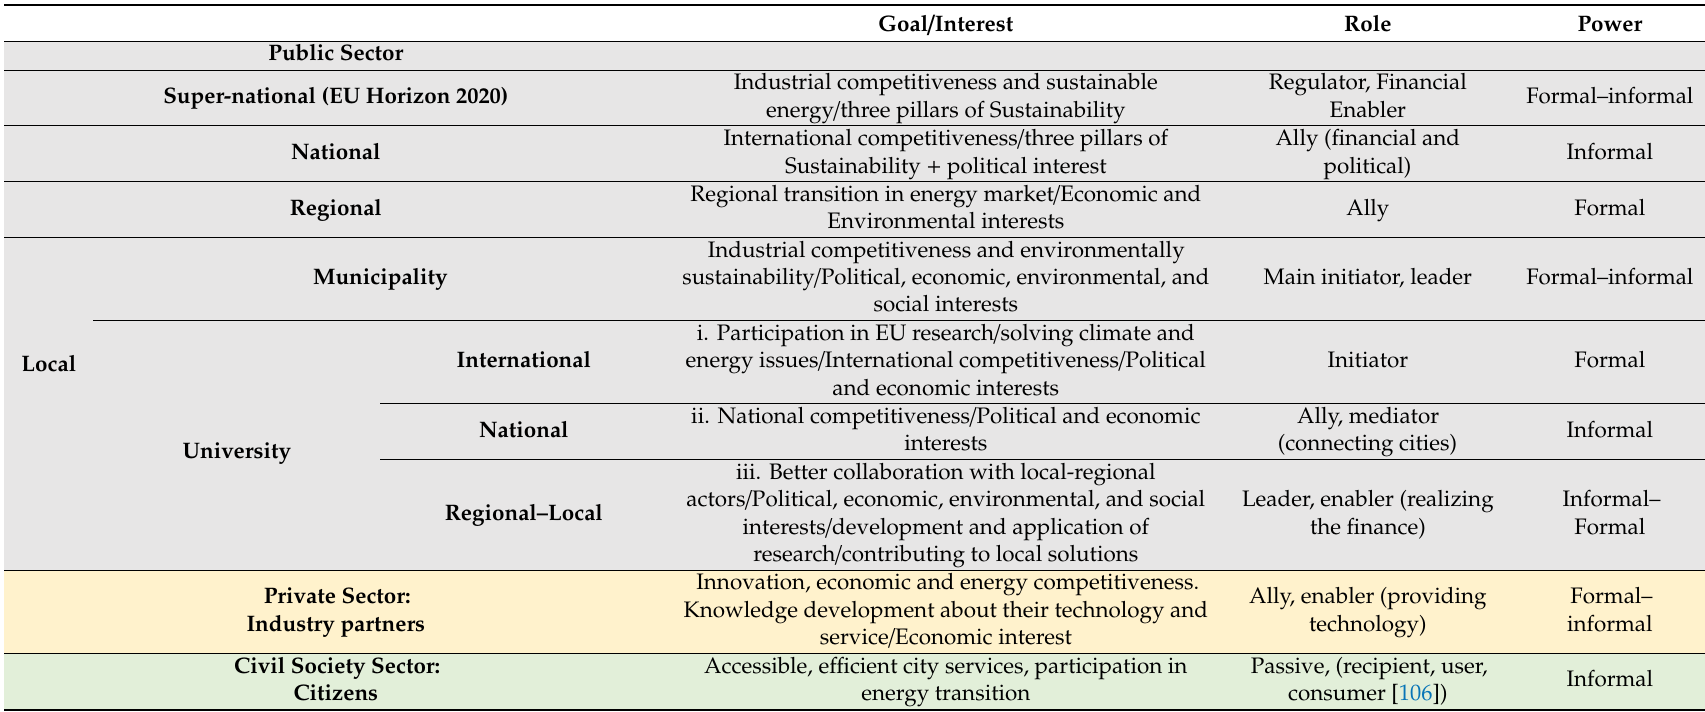
Table 1. Governance in the development of a smart city in